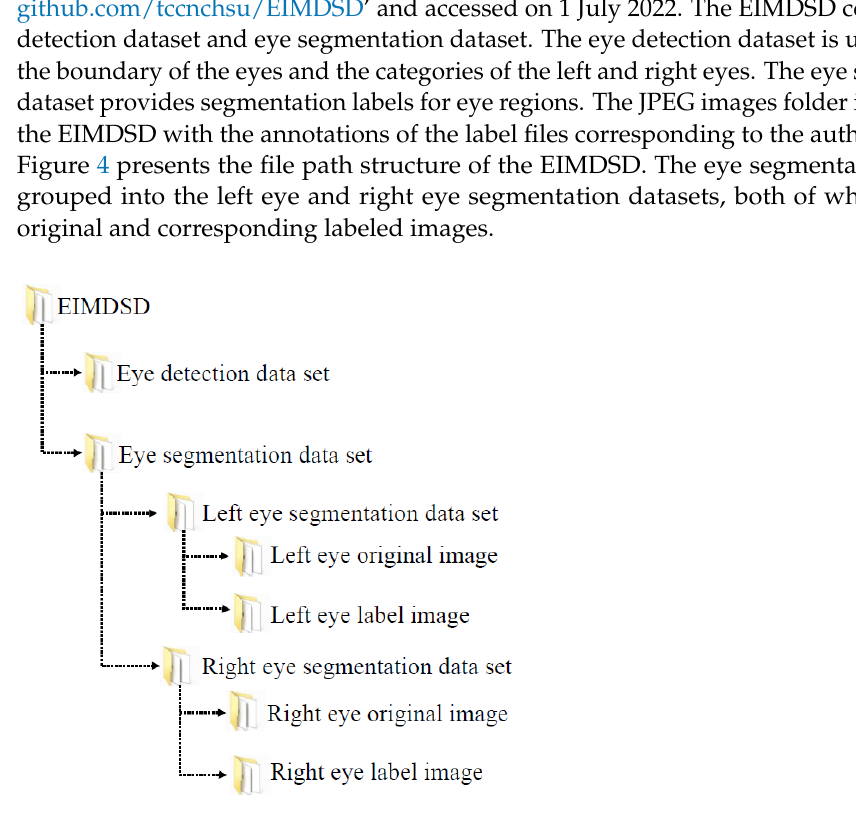
Figure 4. File directories of eye image detection and segmentation dataset (EIMDSD).